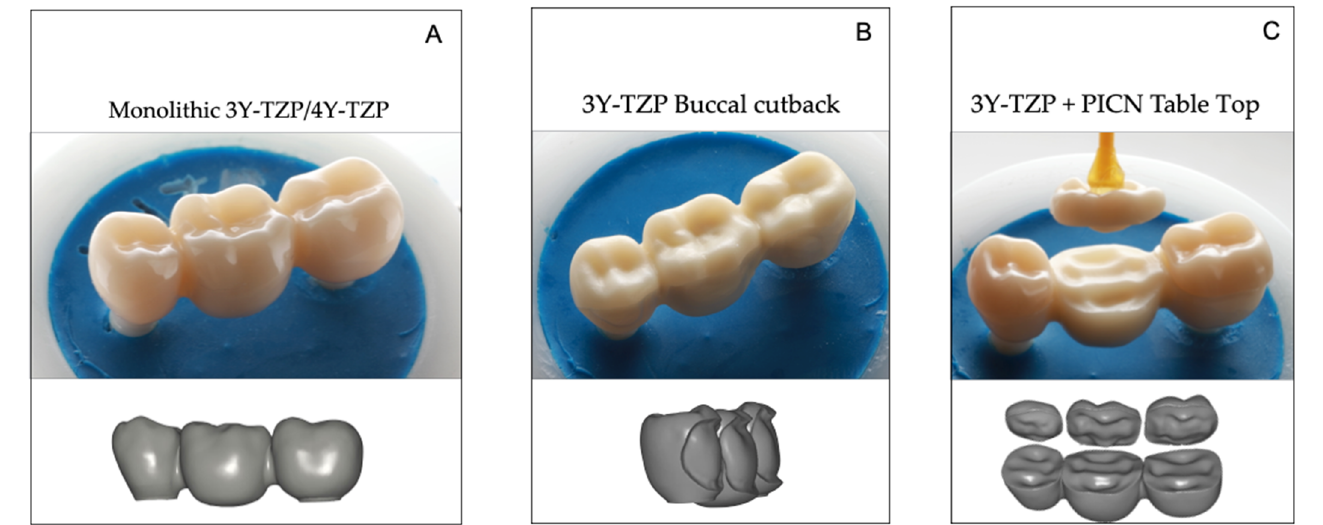
Figure 2. Digital restoration design: ( A ) Master design for monolithic Groups Z-HT and Z-ST; ( B ) Bi-Layer Group FL with facial veneering; ( C ) Split design of Group RL into 3-YTZP framework and PICN tabletop.